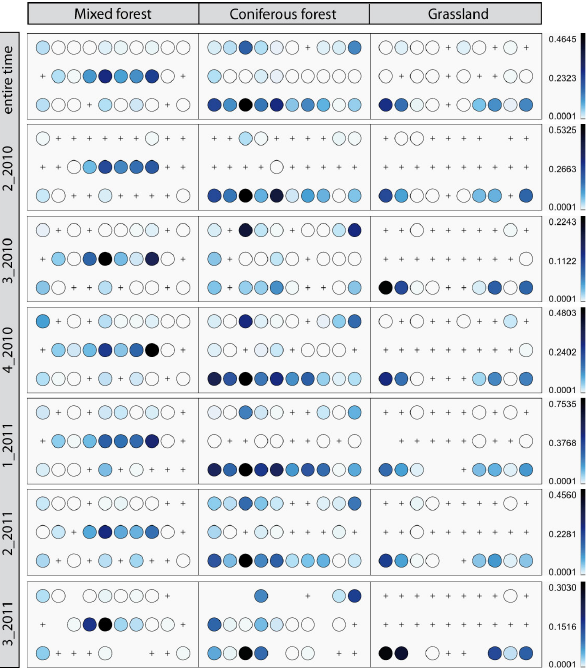
Fig. 3. Water table response variable WT NORM per hillslope and transect for the entire time series (18 months) and per season (1 2011: January/February/March, 2 2010/2011: April/May/June, 3 2010/2011: July/August/September 2010, 4 2010: Octo- ber/November/December). A cross represents a dry well, a white spot missing